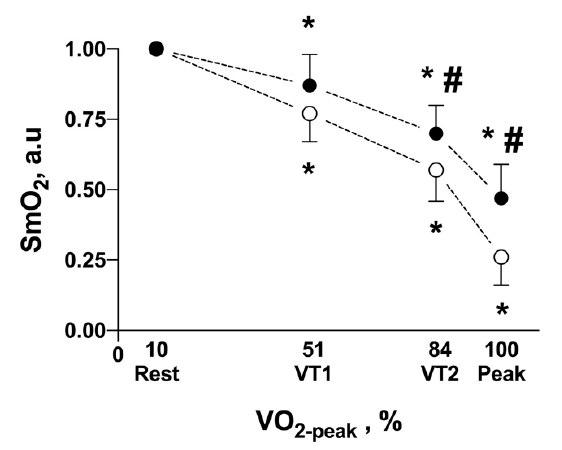
Figure 5. Oxygen saturation (SmO 2 ) in respiratory ( m.intercostales , solid circles) and locomotor muscles ( m.vastus laterallis, hollow circles) in the triphasic model of exercise intensity. Values are expressed as an arbitrary unit (a.u). * p < 0.05 respect to rest-phase; # p < 0.05 comparison between muscles.